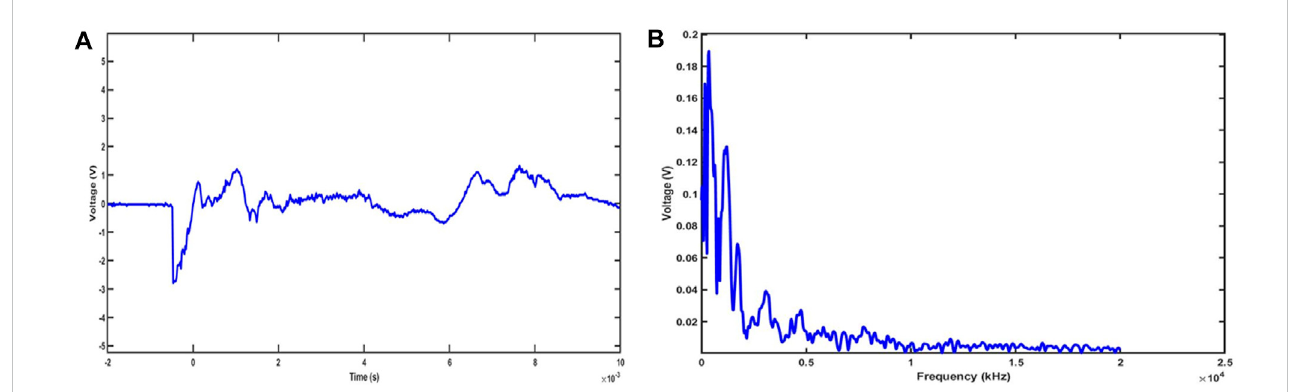
Representative Impulse waveform (A) and frequency spectrum (B) of blast overpressure at 23 psi (~172 dB